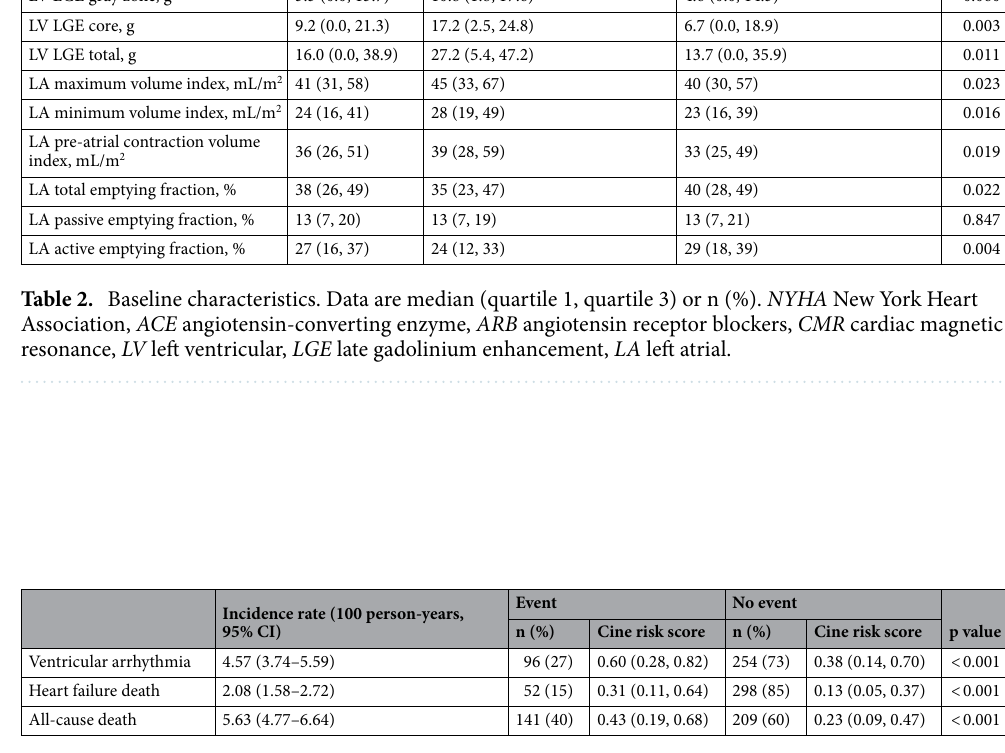
Table 3. Incidence rate and cine risk score for each endpoint. Cine risk score is shown as median (quartile 1, quartile 3). Cine risk score between different endpoints cannot directly be compared because the network was re-trained for each outcome